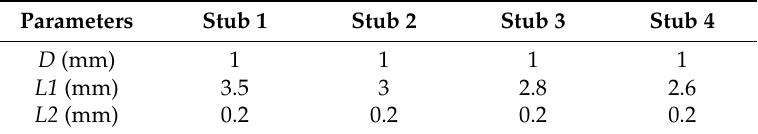
Table 1. Final design parameters for the